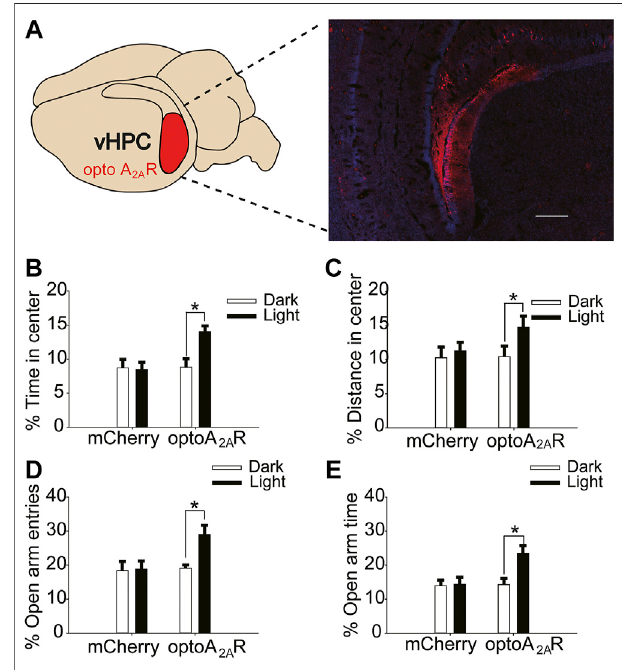
FIGURE 7 | Targeted expression and light activation of optoA 2A R in the vHPC alleviates caffeine-induced anxiety. (A) Selected expression of AAV-optoA 2A R or AAV-mCherry in the vHPC (Scale bar = 500 μ m). (B,C) Behavior of the four groups of mice in the open- fi eld test ( n = 7). Light stimulation of opto-A 2A R in the dHPC increased the percentage of open- arm entries (B) and the percentage of time spent in the open arms (C) . (D,E) Behavior of the four groups of mice in the Elevated Plus Maze (EPM) test ( n = 7). Light stimulation of opto-A 2A R in the dHPC increased the percentage of open-arm entries (D) and the percentage of time spent in the open arms (E) . Data are presented as the mean ± SEM. * p < .01 using two-way ANOVA followed by Bonferroni post hoc